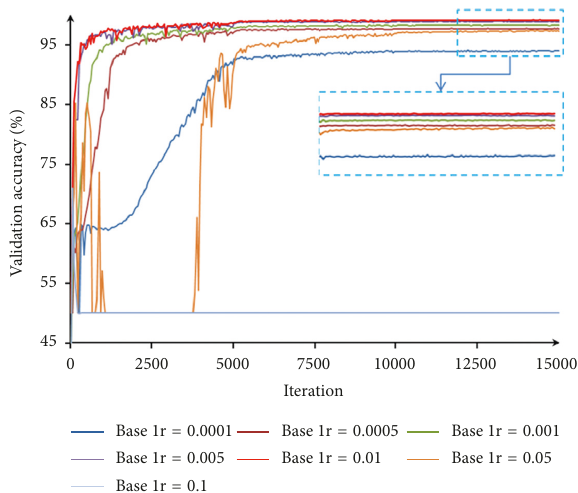
Figure 7: Validation accuracies under different base learning rates. base lr base learning rate. (cid:31)